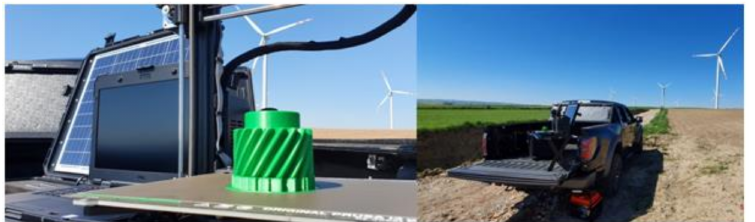
Figure 4. MEX-based mobile system for the manufacture of spare parts under field